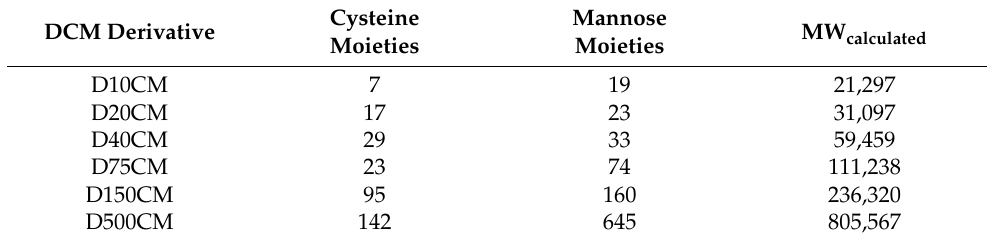
Table 1. Group density and molecular weight of D10CM–D500CM dextran derivatives.